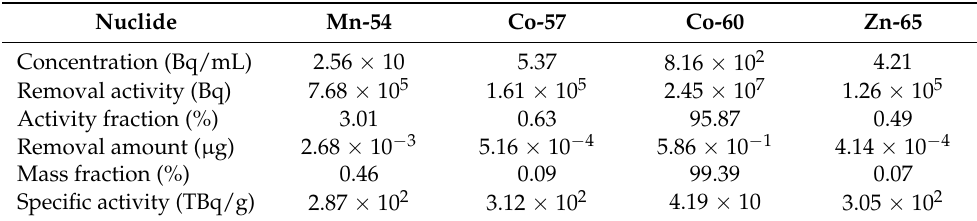
Table 3. Concentrations of radioactive nuclides in the wastewater (30 L) after the decontamination test of the RCP shaft